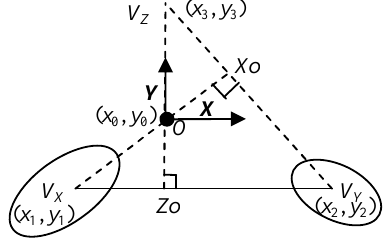
Figure 4. Vanishing points geometry and error ellipse.